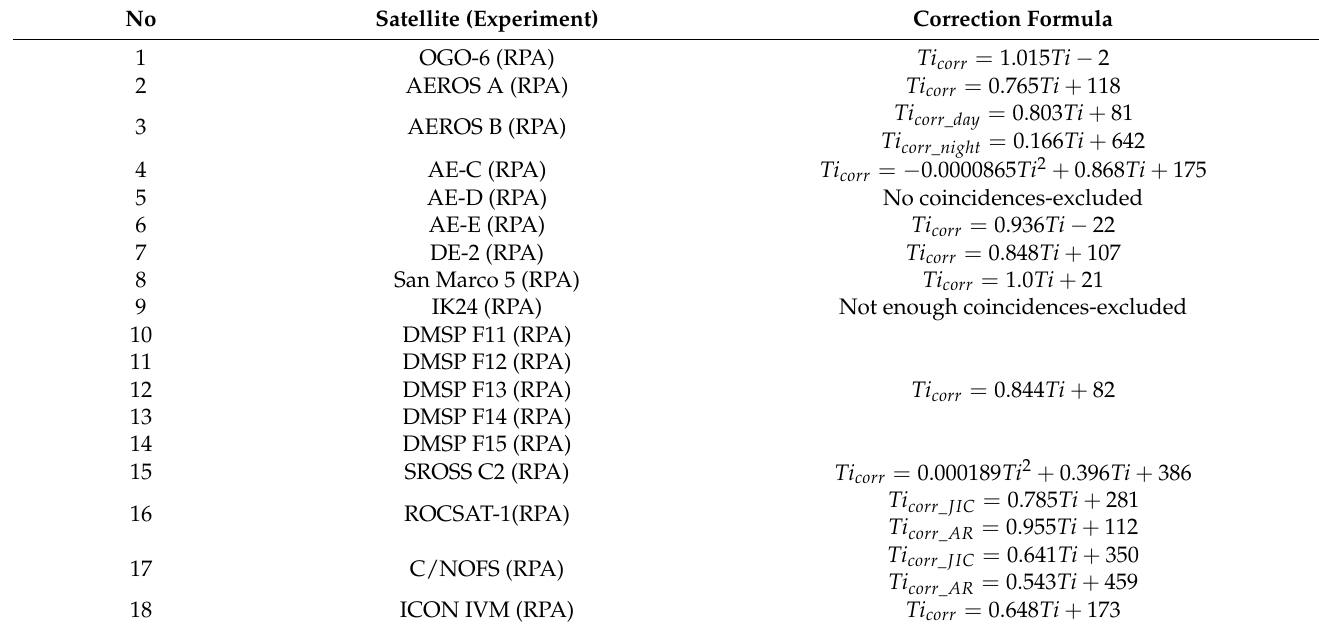
Table 3. Correction formulas proposed for the Ti values from the experiments included in our